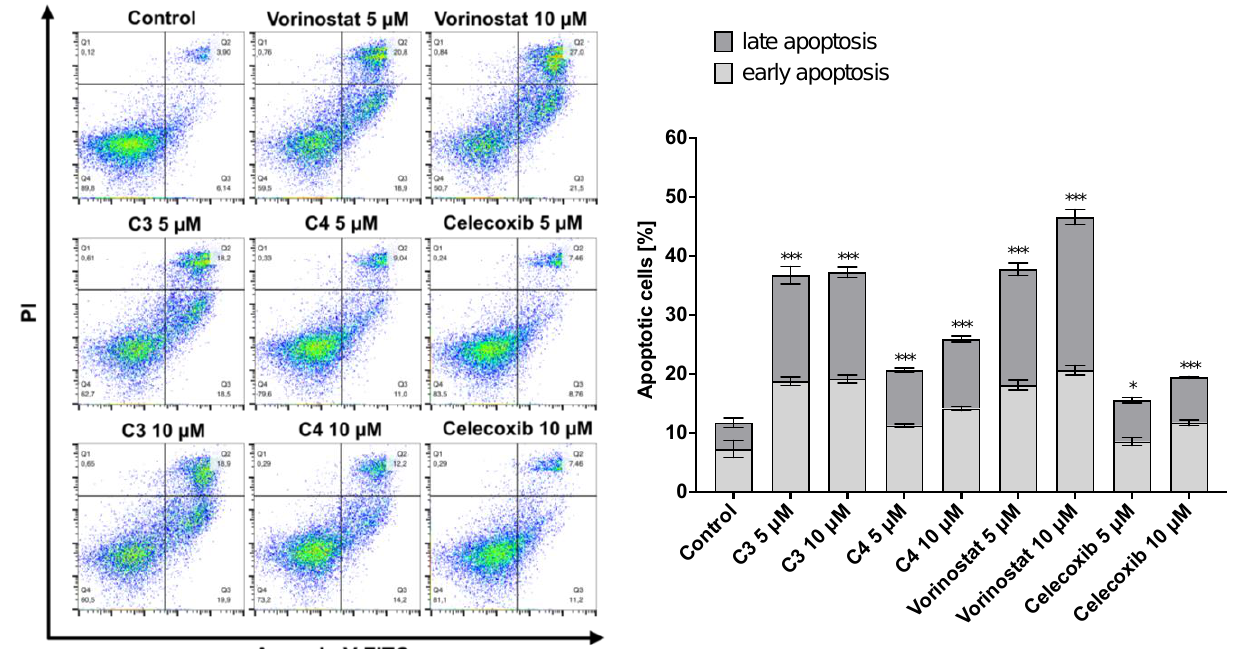
Figure 2. Apoptosis of PC-3 cells induced by C3 , C4 , vorinostat, and celecoxib. C3 , C4 , vorinostat, and celecoxib were incubated with PC-3 cells for 72 h at the indicated concentrations and apoptosis was detected by annexin V and PI staining; representative data of n = 2 independent experiments performed in triplicates. Statistical analysis to compare annexin V positive cells with control was performed using one-way ANOVA (* p < 0.05, *** p < 0.001).